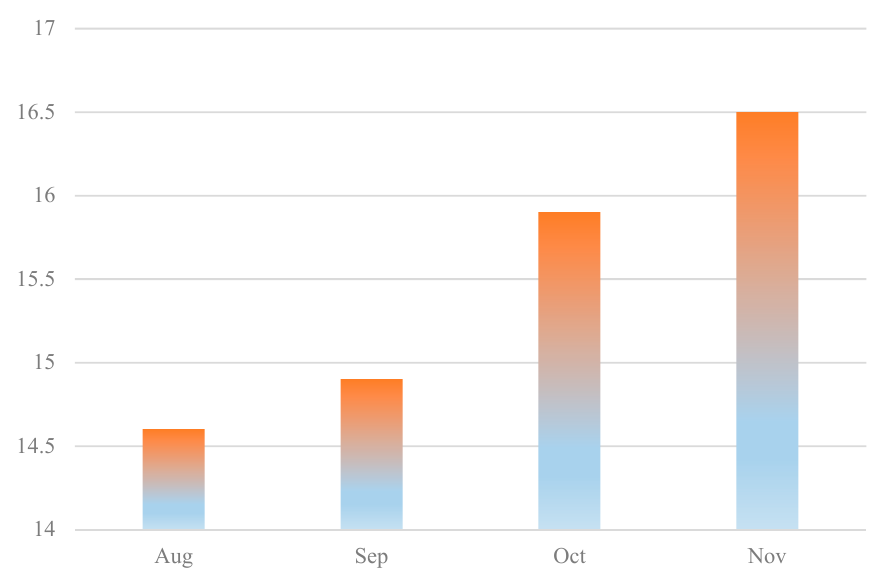
ffi ciency of the PV subsystem from August to Figure 17. Overall efficiency of the PV subsystem from August to November. Figure 17. Overall efficiency of the PV subsystem from August to November. Figure 17. Overall e